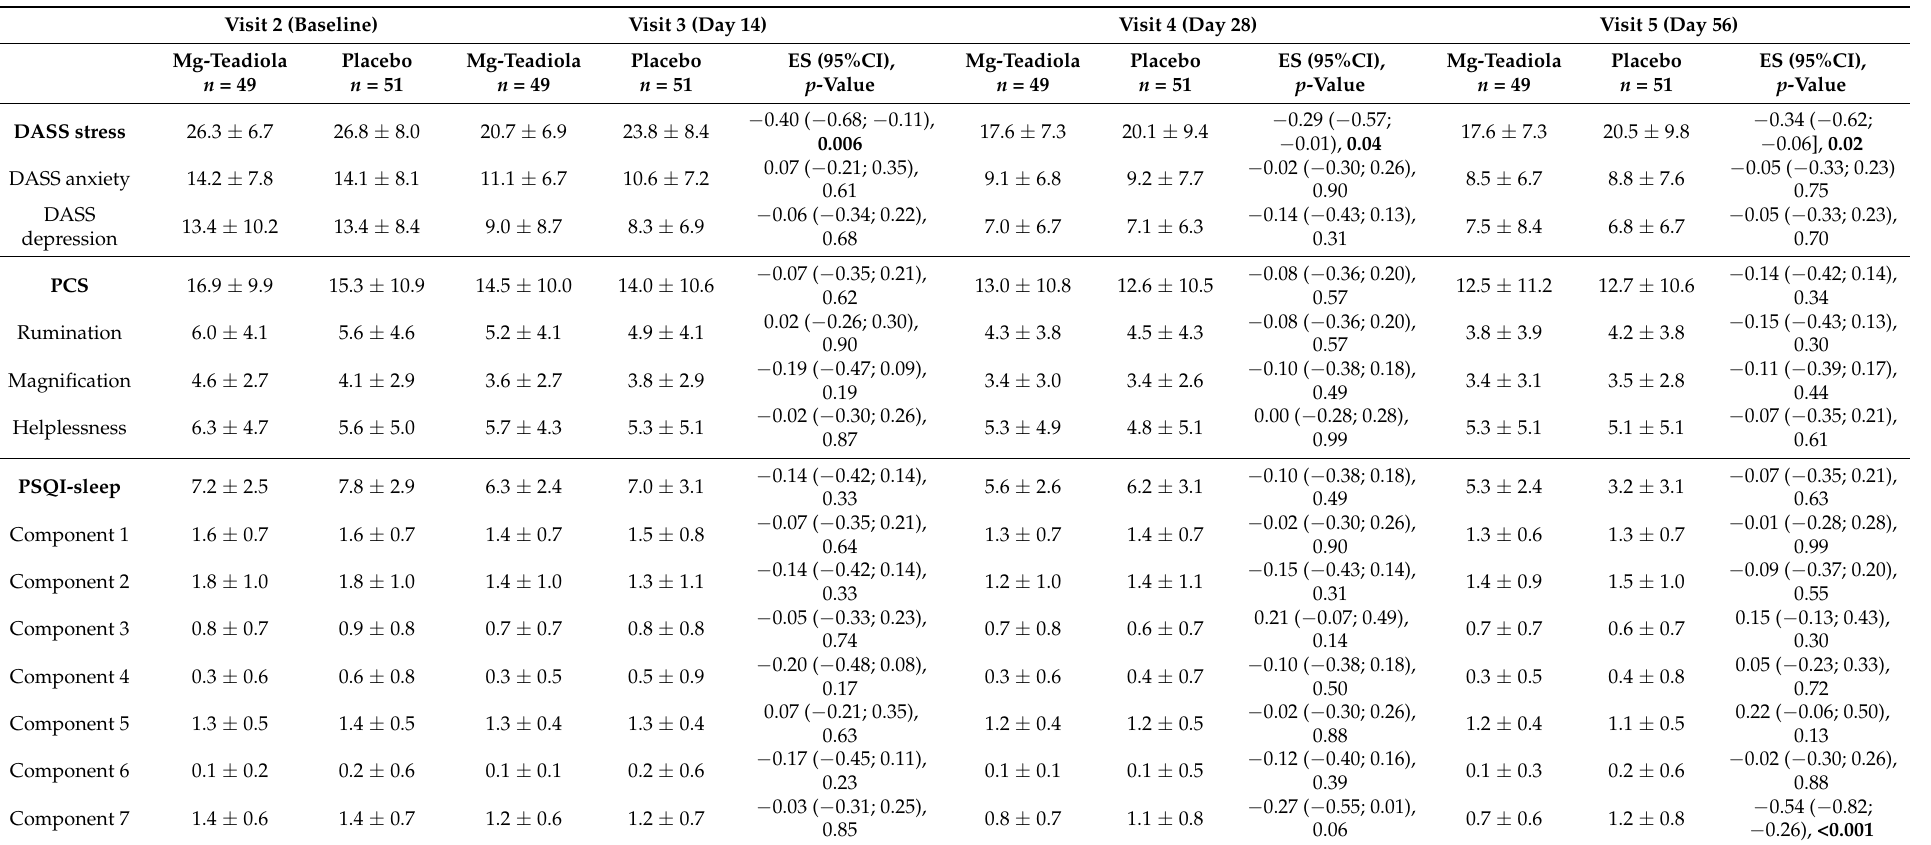
Table 1. DASS-42 stress, PCS-catastrophism, and PSQI-sleep scores; sensitivity to pain; and magnesium levels at baseline and all visits, following supplementation with Mg-Teadiola versus